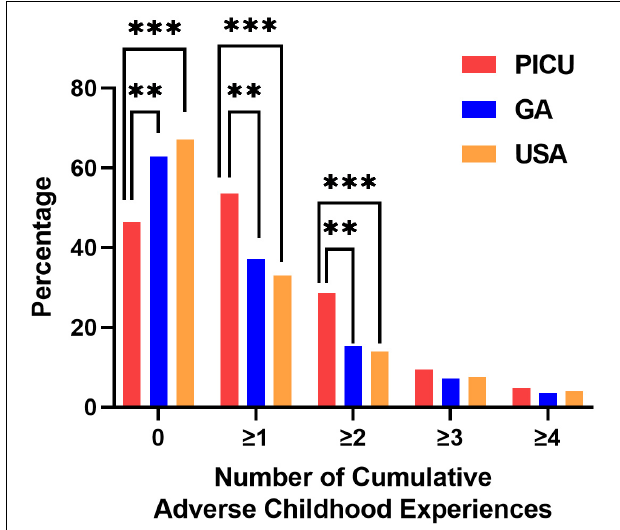
FIGURE 3 | Number of cumulative adverse childhood experiences. Children admitted to the pediatric intensive care unit (PICU) had a higher percentage of experiencing ≥ 1 or ≥ 2 adverse childhood experiences compared to the general population of children living in Georgia or the United States. Children admitted to the PICU (red bars, n = 84); weighted responses of children living in Georgia from the National Survey of Children’s Health (blue bars, n = 1,889); weighted responses of children throughout the United States (USA) from the National Survey of Children’s Health (orange bars, n = 97,173). Only complete cases were included in the analysis. Rao-Scott Chi-square tests were used to compare differences between groups. ∗∗ p < 0.01, ∗∗∗ p <